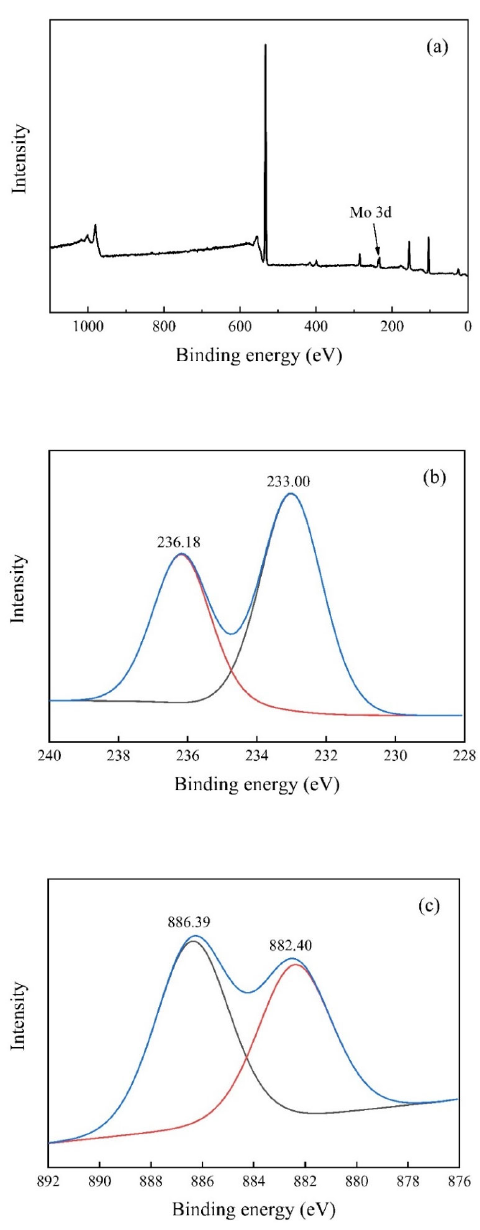
Figure 4. XPS spectra of Ce/MoO 3 /SiO 2 : ( a ) survey, ( b ) Mo 3 d , and ( c ) Ce 3 d.